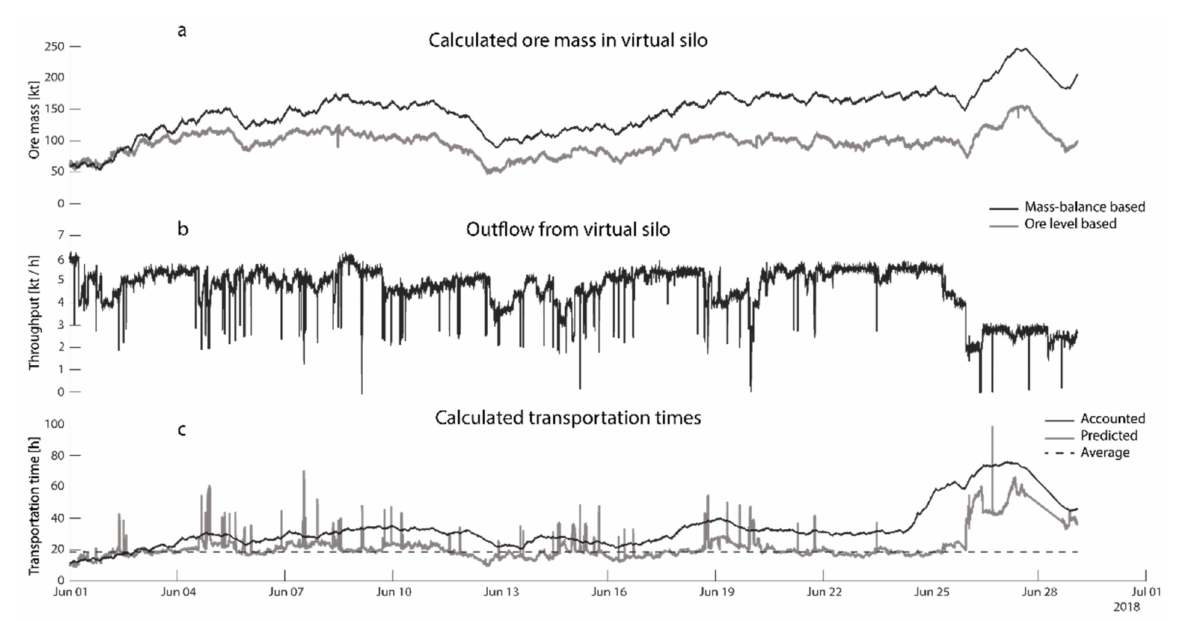
Figure 12. Subfigure ( a ) shows the calculated ore mass based on the mass-balance (black) and the ore levels (grey). Subfigure ( b ) shows the outflow. Subfigure ( c ) shows the average (dashed), the accounted (black) and the predicted (grey) transportation times in June.